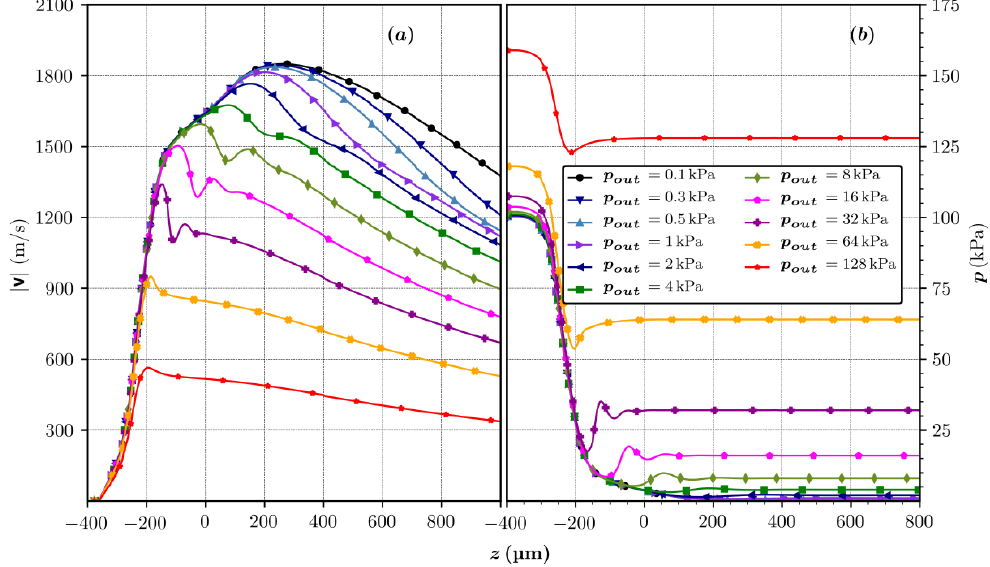
Figure 4. ( a ) Velocity and ( b ) pressure profiles along the symmetry axis of the nozzle with L d = 200 µm and θ d = 15°, as a function of the outlet chamber pressures. The length of the outlet throat was varied from the nominal of 40 µm [19] to a maxi- mum of 250 µm while keeping the angle at 0 o , to investigate its influence on jet formation, its stability, and the acceleration (Figure 5a). In Figure 5b the length of the diverging part was kept constant at 200 µm and the diverging angle was increased from 12.5° to 17.5°. A range of geometric schemes is consistent with the data from Table 3. Figure 5. Scheme of the nozzles for 6 selected outlet orifice designs from Table 3: ( a ) zero diverg- ing angle with different extending lengths, ( b ) constant diverging length of 200 µm with varying diverging angles.